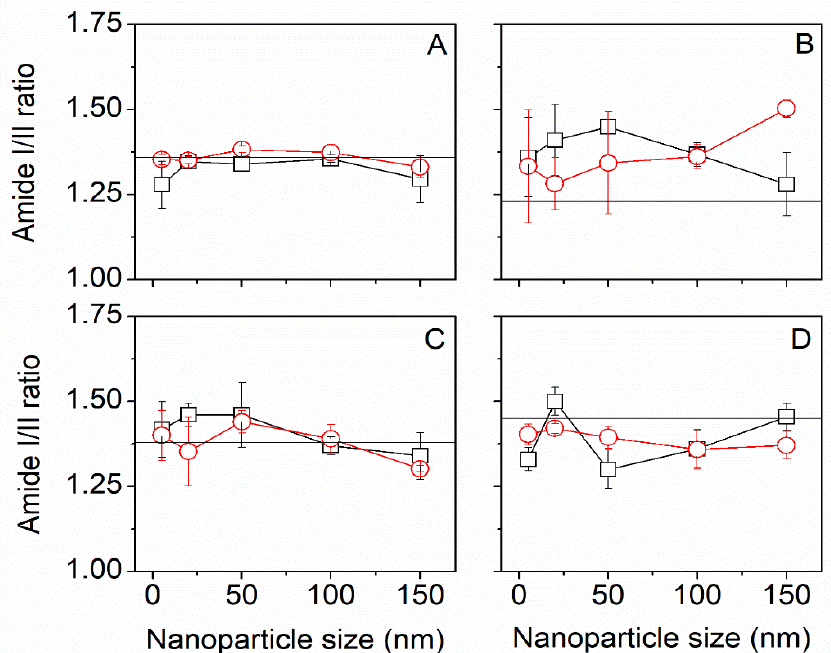
Figure 4. FTIR-ATR change in amide I/ II ratio for Mulberry ( A ), Eri ( B ), Muga ( C ), and Tasar ( D ) silks. Black squares ( (cid:3) ) are scCO 2 samples, red circles (O) are control samples. The horizontal line is the amide I/II ratio in native silk. We found that for scCO 2 treatment alone, the amide I/II ratio was not significantly different from the native silks.